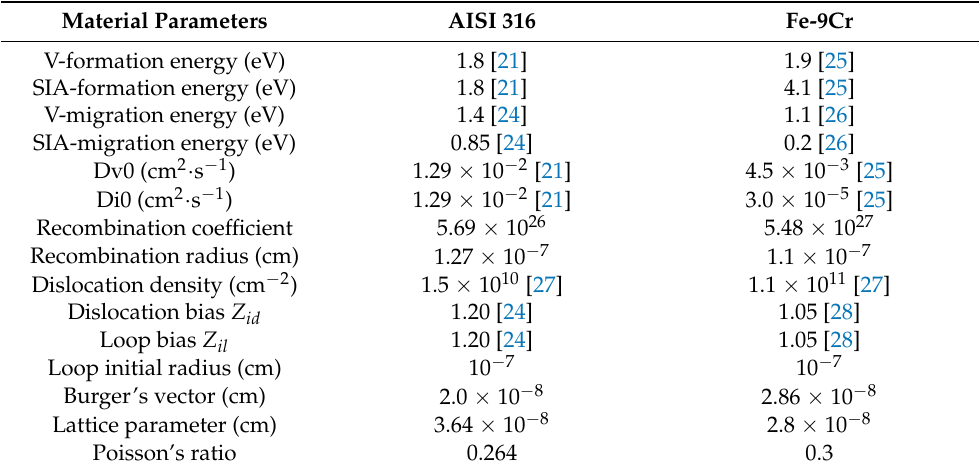
Table 2. Material parameters for austenitic AISI 316 and F/M Fe-9Cr binary alloy.